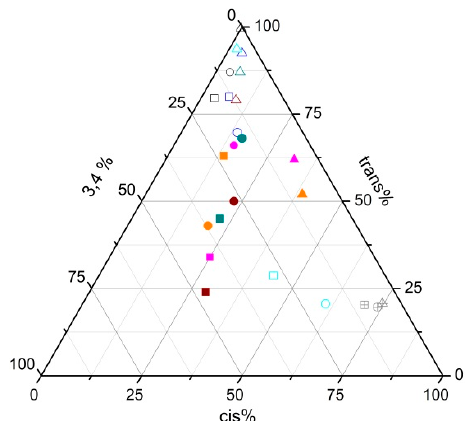
Figure 2. Ternary plot of the microstructures of the polyisoprenes obtained from [Cp*Ln(AlMe 4 ) 2 ] ( 1 Ln ). Polymers produced applying cocatalyst ( A ) are represented by circles, those produced with cocatalyst ( B ) by squares and products of activations with cocatalyst ( C ) are represented by triangles. Solid symbols mark reaction times of 1 h, hollow symbols mark reaction times of 24 h and hollow and crossed symbols mark reaction times of 15 min. The metal centers of the precatalyst is color-coded as follows: black (La), blue (Nd), teal (Gd), pink (Tb), orange (Dy), brown (Ho), cyan (Y), and grey (Lu). Data of the La, Nd, and Y analogues are shown for comparison [13].